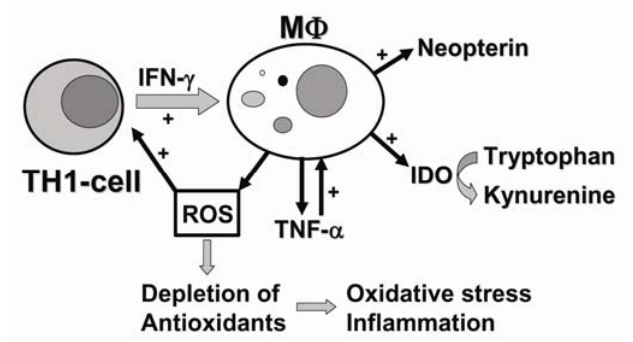
Figure 1. In the course of the adaptive immune response, activated T-helper (Th)1-type immune cells produce cytokines such as interleukin-2 or interferon- γ (IFN- γ